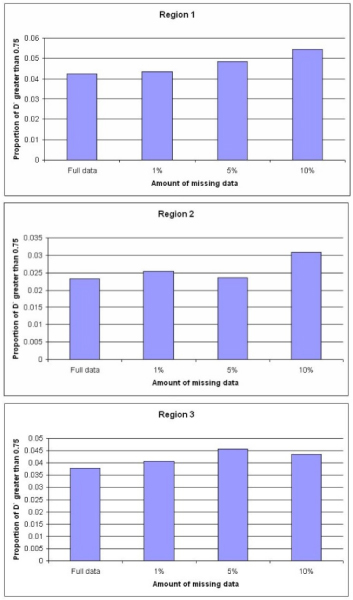
Varying proportions of strong D' with increasing degrees of missing data. Histograms of the proportion of pair-wise comparisons exhibiting a D' value greater than 0.75 for varying degrees of missing data.